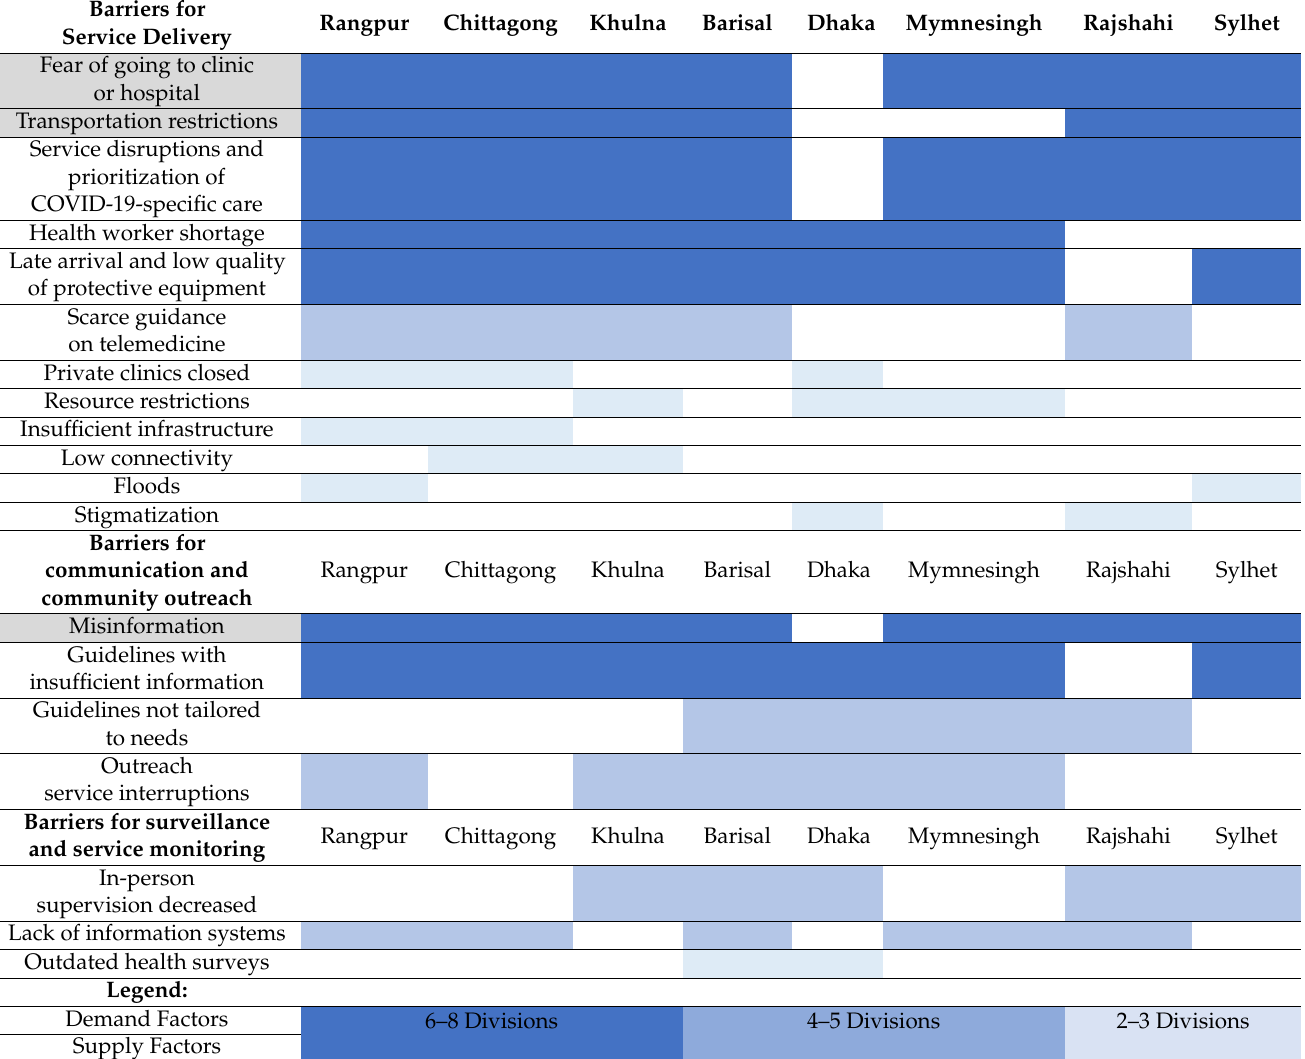
Table 2. Barriers identified for service delivery by